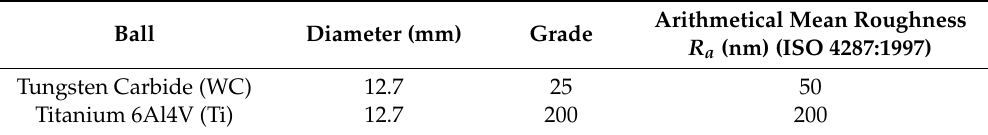
Figure 3. Four-ball test setup and the ball configuration and geometry. All dimensions are given in mm. Table 2. Ball